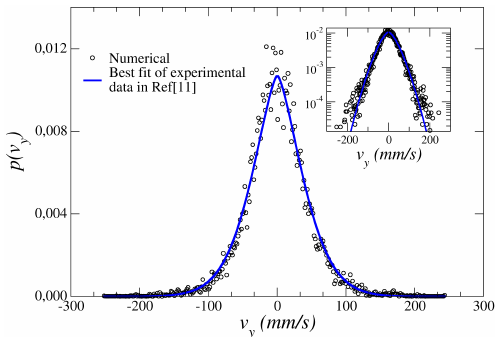
Figure 2. Speed distribution p ( v y ) on the y direction (non- moving walls), obtained for A = 1mm and f = 30Hz. The inset shows the same but in semi-log. The best fit of the experimental distribution of v y from Ref. [11] is shown for